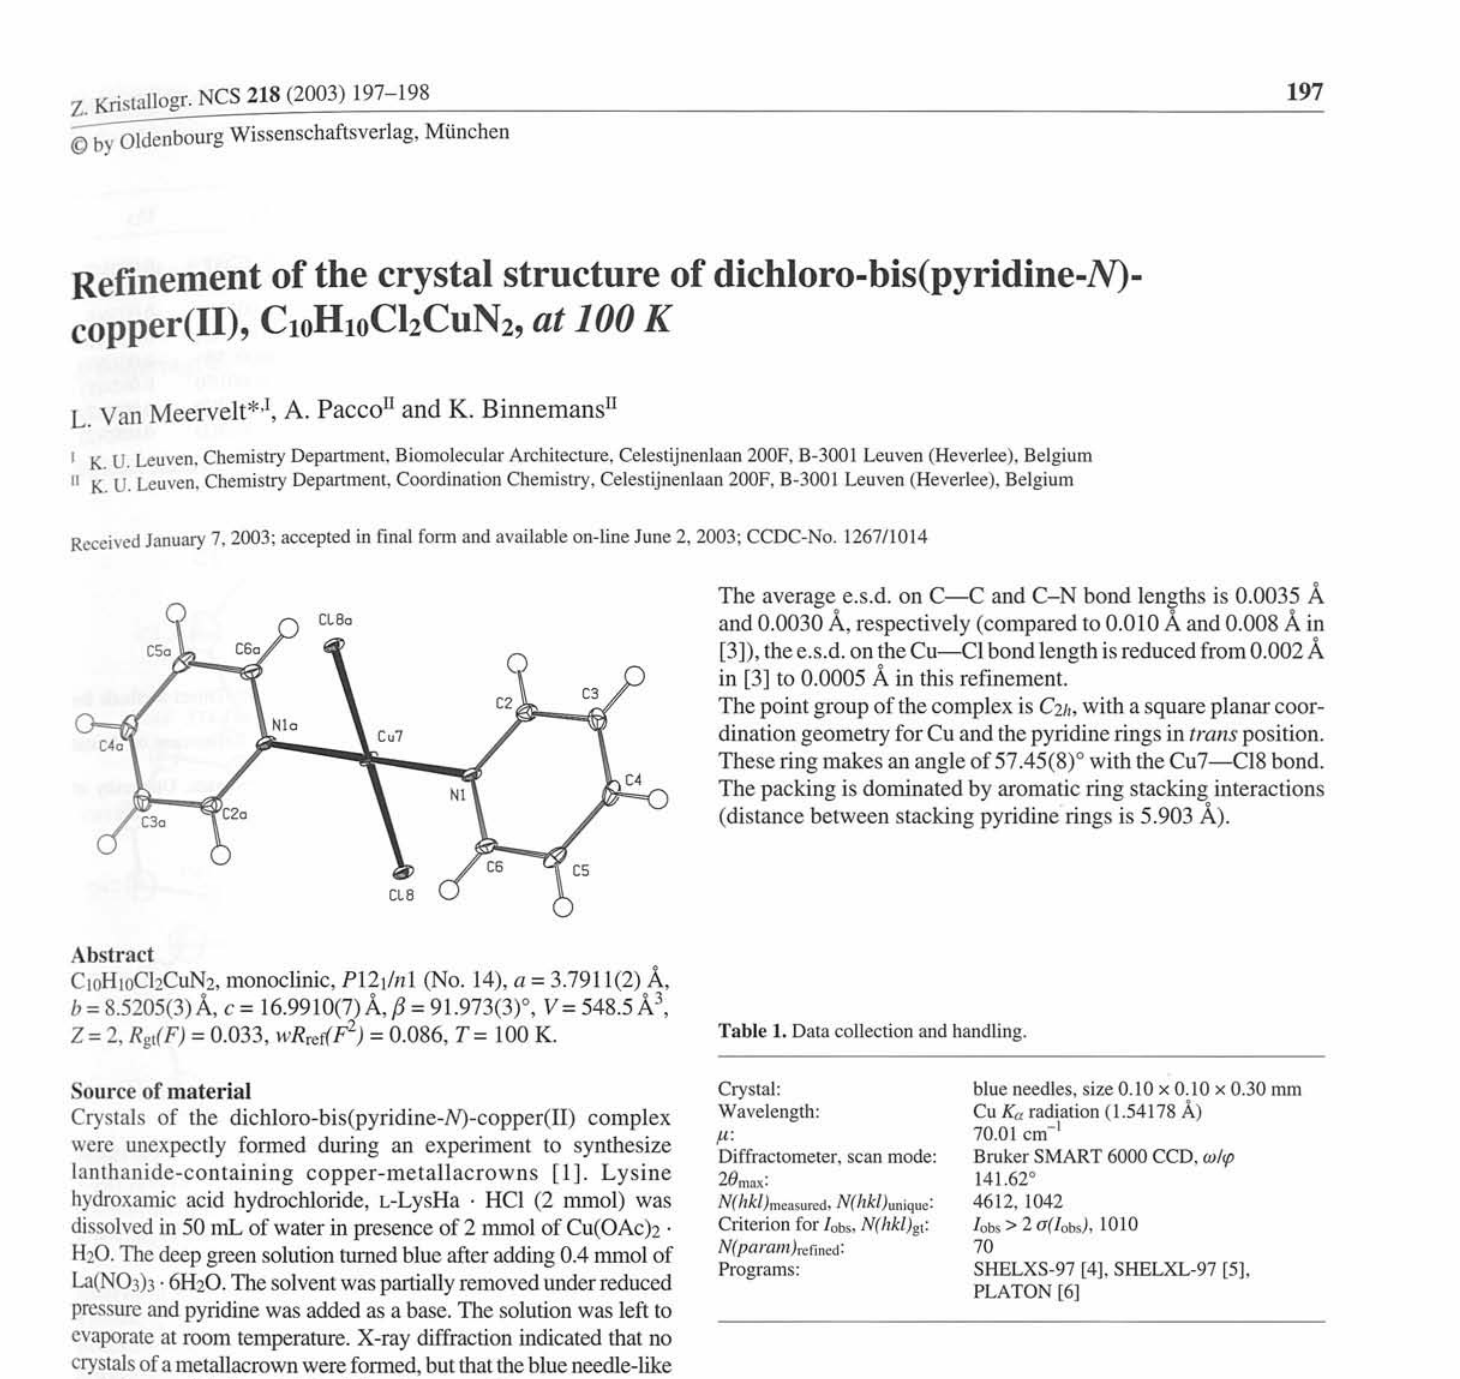
Table 2. Atomic coordinates and displacement parameters (in À 2